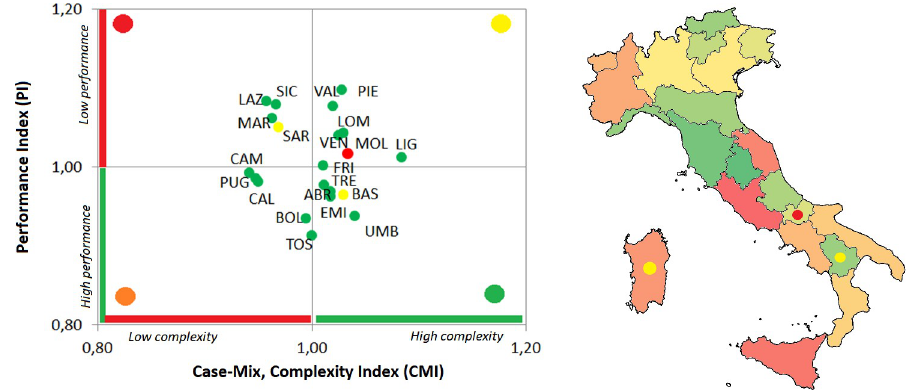
Fig 4. Overall classification of each Italian region considering both the hospital bed management indicators and the complexity and performance indicators. In both figures the colour of the marker captures the hospital bed management classification. In the Italian map, regions are coloured on the basis of the ratio between the CMI and PI.